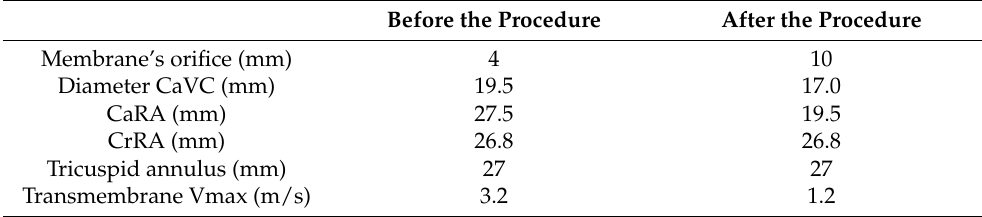
Table 2. Echocardiographic measurements of case 2 before and after the procedure. Before the Procedure